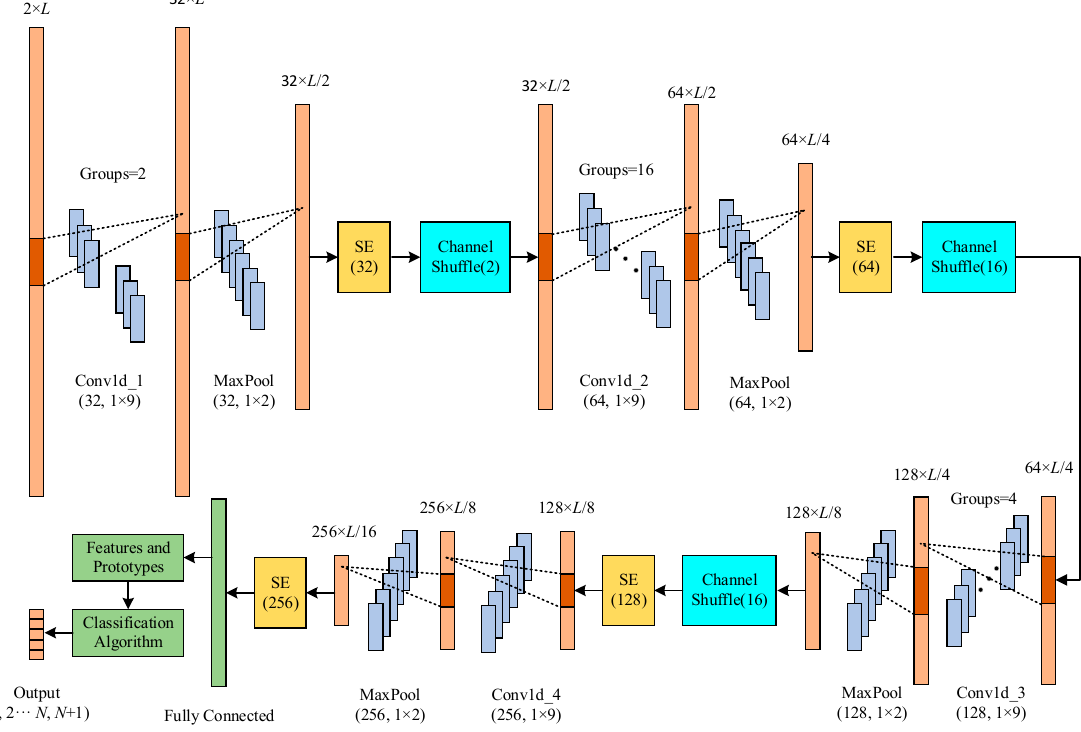
Figure 2. The network structure for open-set recognition.